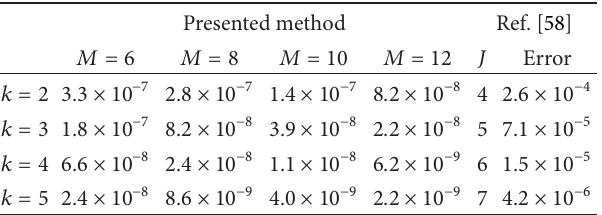
Table 7: Comparison of maximum absolute errors in 𝑦(𝑡) in [58] and the ones obtained by current method for Example